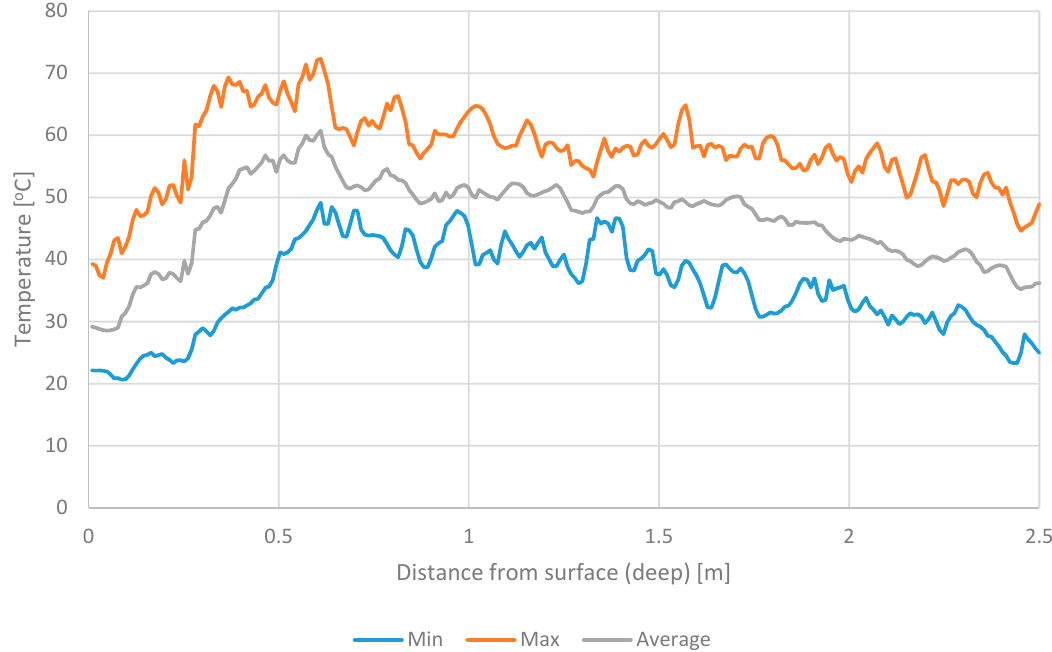
Figure 1. The temperature of refuse-derived fuel (RDF) at different depths.